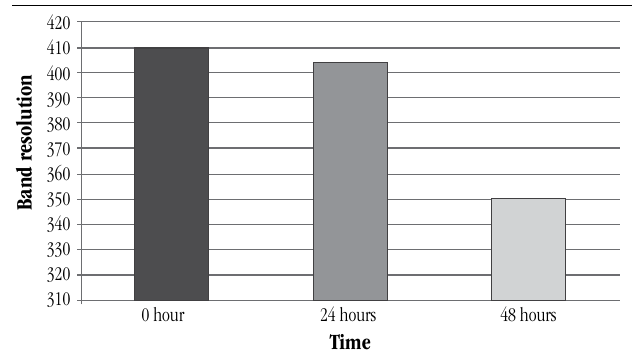
figurE 2 – Average number of bands, per subject, at the different culture times